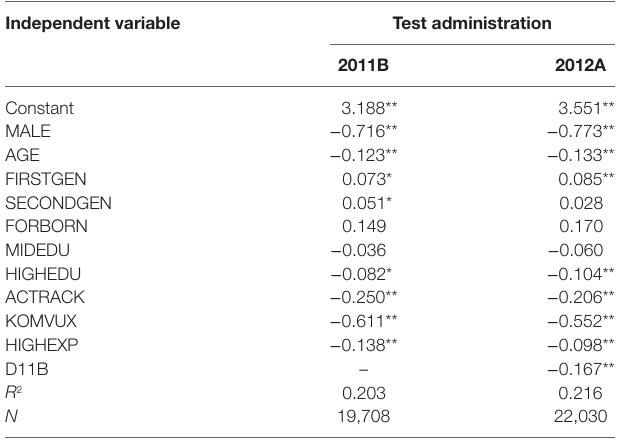
taBlE 2 | Least squares estimates of score differences between grade point average (GPA) and Swedish admissions test